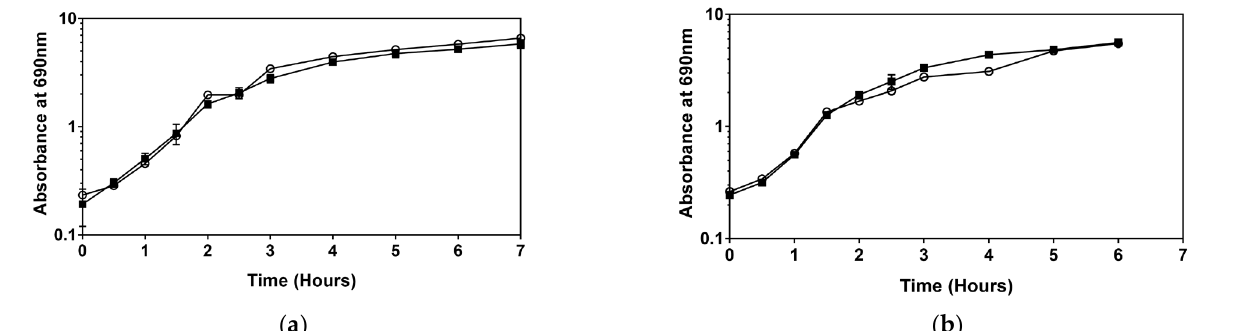
Figure 3. Growth comparison of supplementation with sub- MIC levels of Virukill (●) and without Virukill ( ○ ): ( a ) Serratia marcescens ATCC 13880; ( b ) Serratia sp. HRI.